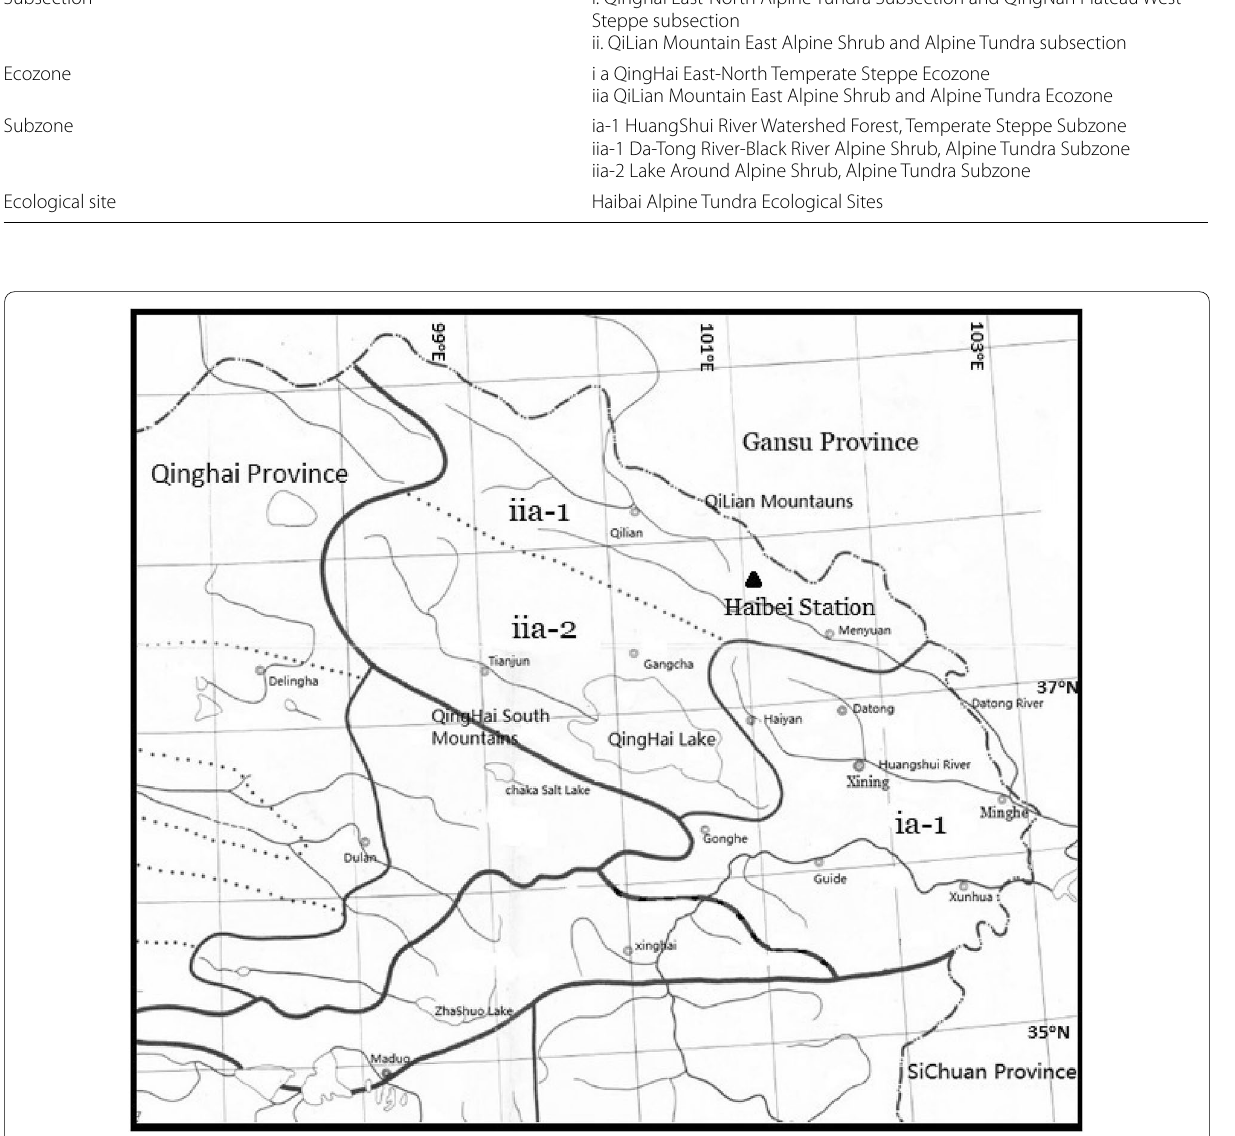
lower hills, and glacier mountains, the ecological sites in Fig. 7C showed a good relation with the eleva- tion, slope, aspect, temperature, and water condi- tion (Table 4) (Zhang et al. 2008). This approach had been demonstrated and applied to the entire region of Qinghai-Tibet Plateau in China (Zhang et al. 2010)